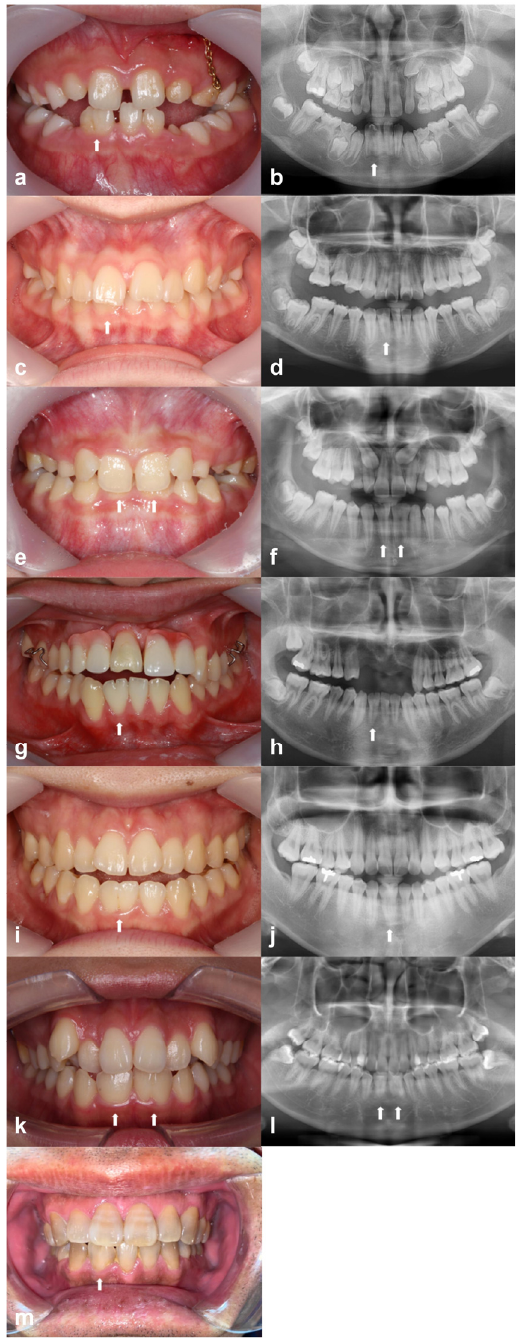
Figure 2. Intraoral and panoramic radiographs, respectively, of: ( a , b ) patient A-1 (Family A); ( c , d ) patient B-1 (Family B); ( e , f ) patient C-1 (Family C); ( g , h ) patient D-1 (Family D); ( i , j ) patient E-1 (Family E); ( k , l ) patient F-1 (Family F); ( m ) intraoral photograph of patient F-2 (Family F).